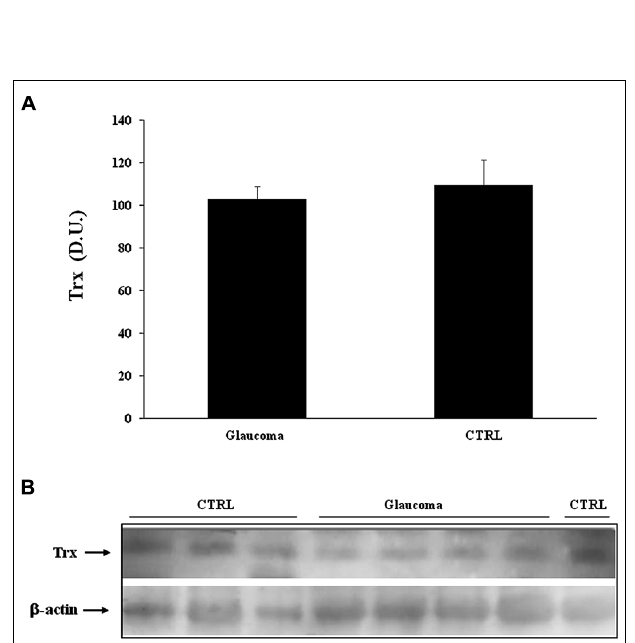
FIGURE 7 | (A) Thioredoxin protein levels in plasma of glaucoma and control subjects. Samples from control and patients with glaucoma were assayed forTrx expression byWestern blot. A representative immunoblot is shown. β -actin has been used as loading control. (B) Densitometric evaluation: the bar graph shows the values are expressed as mean standard error of mean of 3 independent analyses. P < 0.05 vs. control. D.U., densitometric units; CTRL, control.